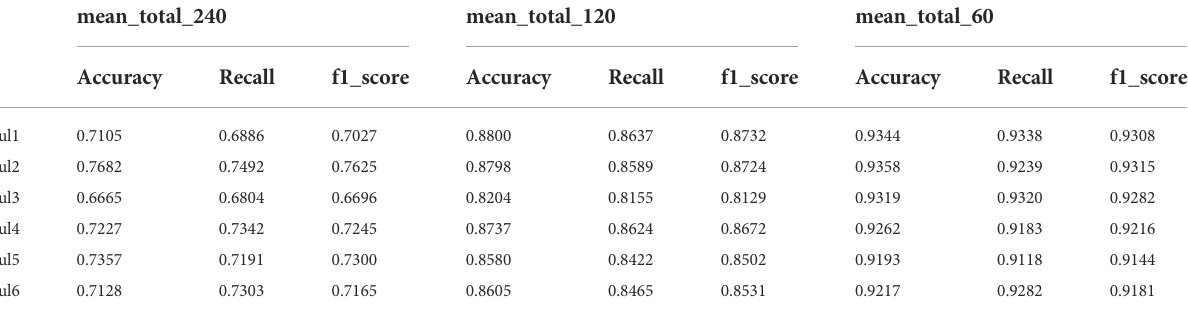
TABLE 3 Mean results of each multilayer networks using MSNA methods.